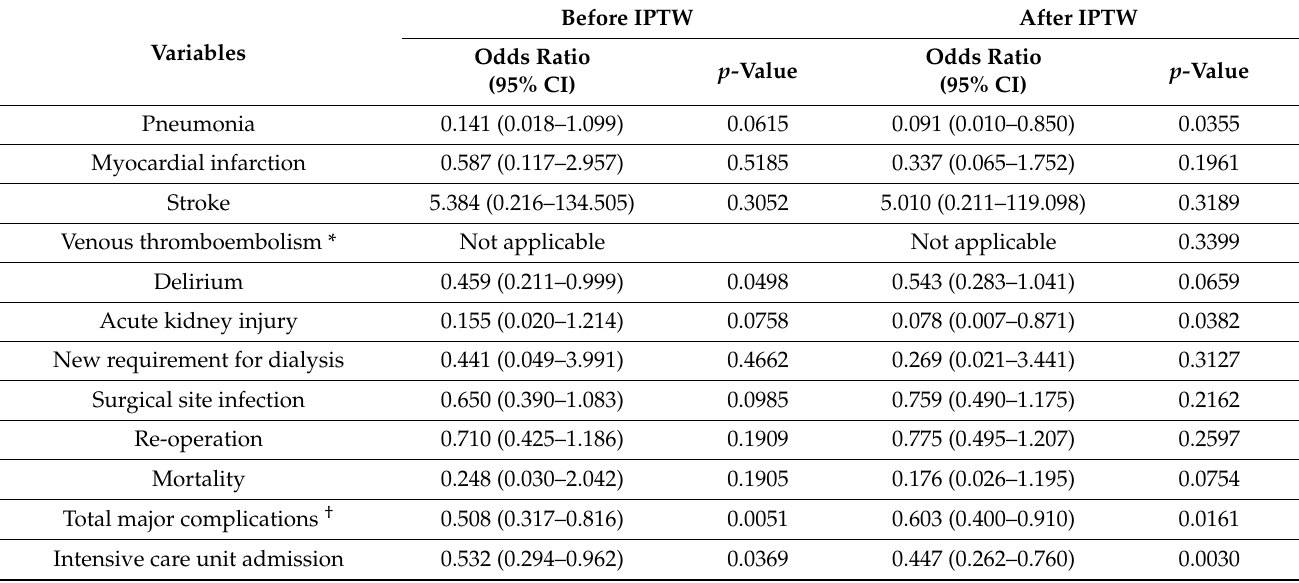
Table 3. Risk of postoperative complications under peripheral nerve block anesthesia.